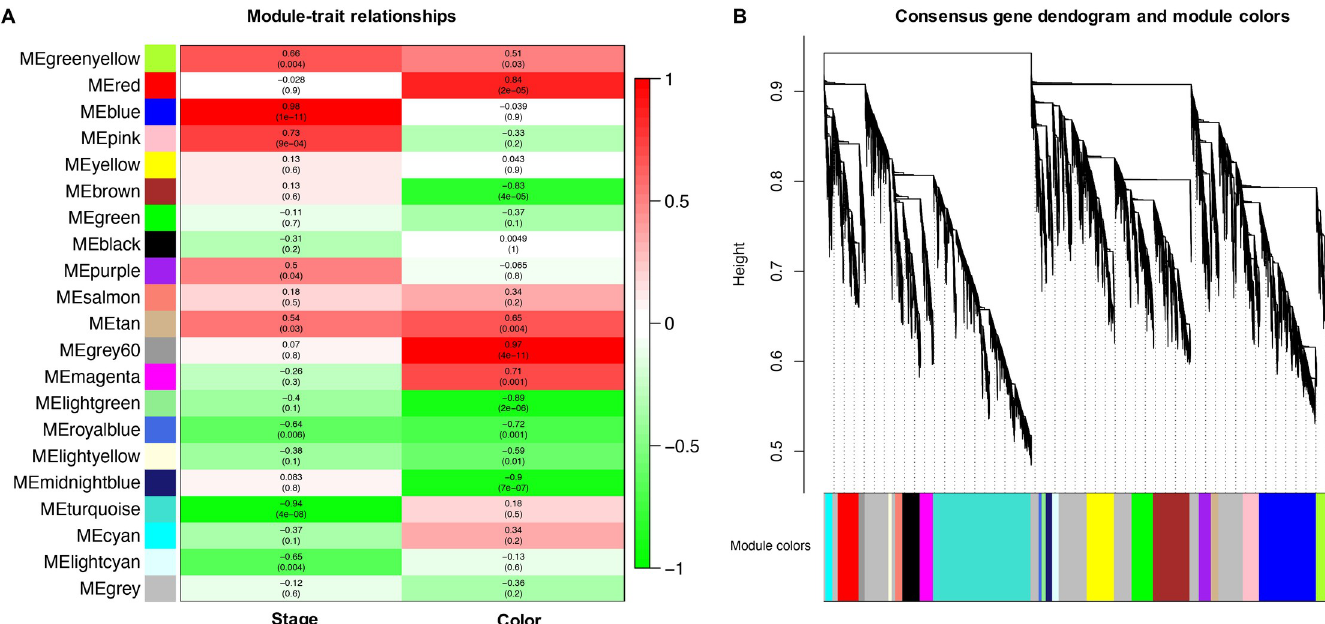
Fig 7. Weighted correlation network analysis of expression across all samples. (A) module-trait correlations and corresponding p -values (in parentheses). Each row corresponds to a module eigengene (ME), and each column to a trait. The color scale on the right shows module-trait correlations from − 1 (green) to + 1 (red). (B) Hierarchical cluster tree showing 21 modules of co-expressed genes. Each of the 8,324 DEGs is represented by a leaf in the tree, and each of the modules by a major tree branch. The lower panel shows modules in designated colors.